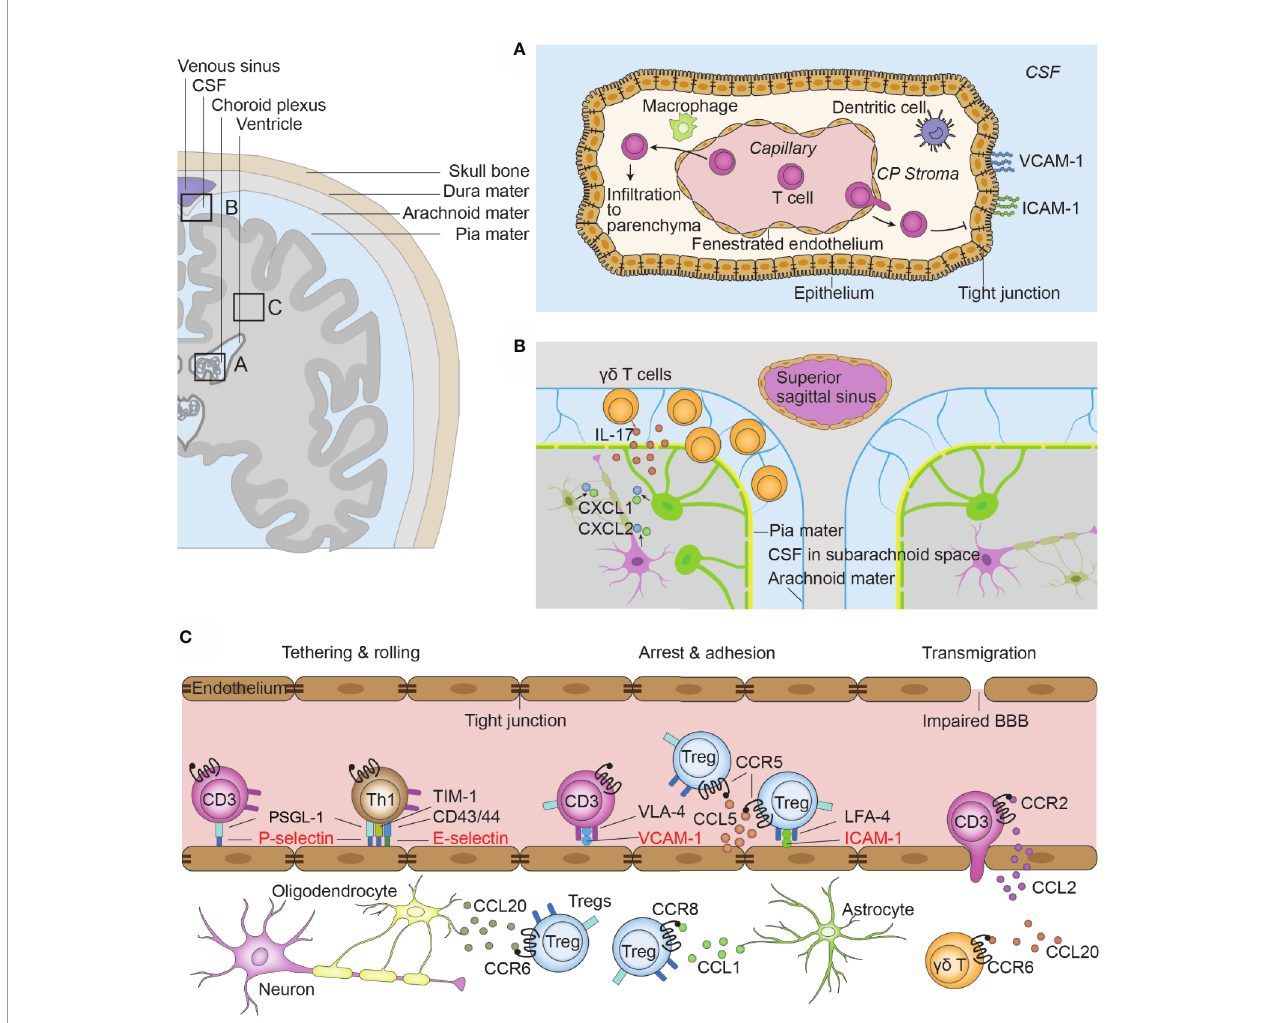
FIGURE 1 | In fi ltration routes of T cells after ischemic stroke. (A) Choroid plexus (CP) T cells in fi ltrate to the CP stroma through the fenestrated capillaries. The tight junctions between epithelial cells and lack of adhesion molecules on the stromal side of the CP hinder T cell transmigration to the CSF. T cells in the stroma directly migrate to the parenchyma from the root of CP. (B) Meninges. gd T cells migrate from the intestines to the brain after ischemic stroke and are preferentially located in the leptomeninges. gd T cells secrete IL-17 and induce the upregulation of CXCL1 and CXCL2 in the parenchyma. (C) Impaired blood-brain barrier in the parenchymal vasculature. T cells are initially tethered by the interaction between PSLG-1 and P-selectins on endothelial cells. Th1 cells also use TIM-1-P-selectin and CD43/44-E-selectin interactions for their tethering and rolling. Further adhesion and arrest of T cells are mediated by integrin and their receptors. VLA-4 and VCAM-1 are universally used by all T cell subsets while the LFA-4 and ICAM-1 pair is preferentially used by Tregs. Further, the chemokine and receptor pair CCL5 and CCR5 facilitates Treg docking on endothelial cells. Chemokine and receptor interaction facilitates interstitial locating in a cell-type-speci fi c